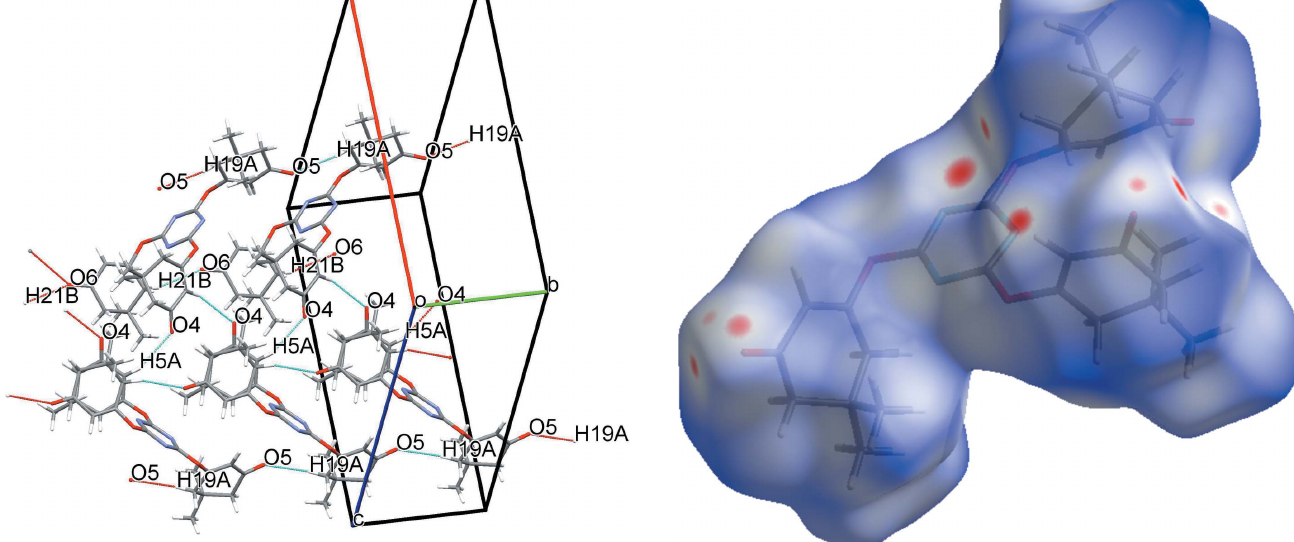
Figure 2 A view of the intermolecular C—H (cid:3)(cid:3)(cid:3) O hydrogen bonds (Table 1) in the title compound.